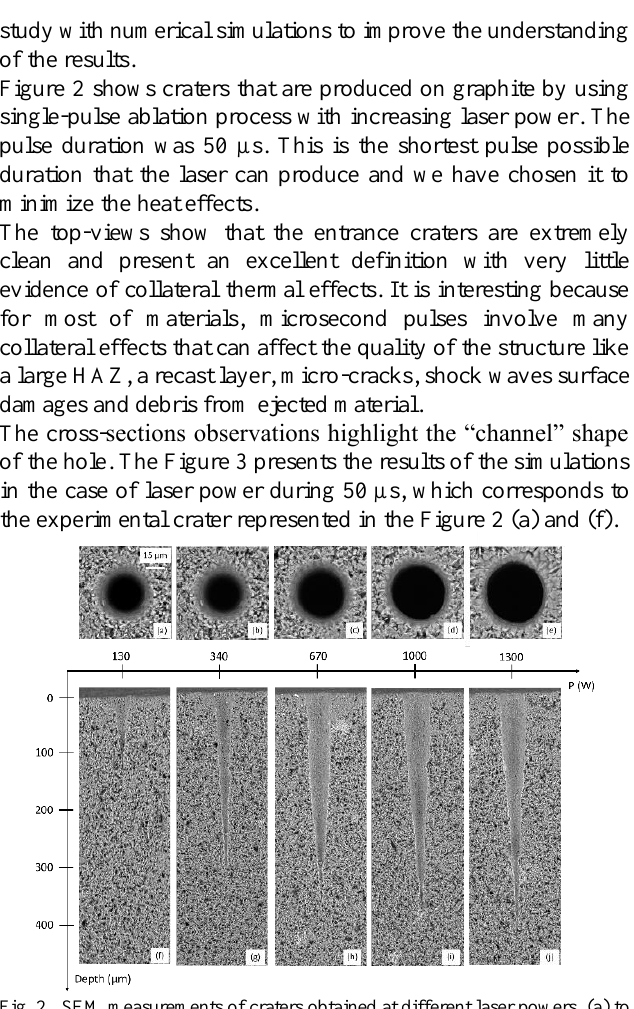
Fig. 3. Simulations of the distribution of temperature, the geometry deformation and the ray propagation in the graphite material at different time (from 1 µs to 50 µs) for a laser power of 130 W.